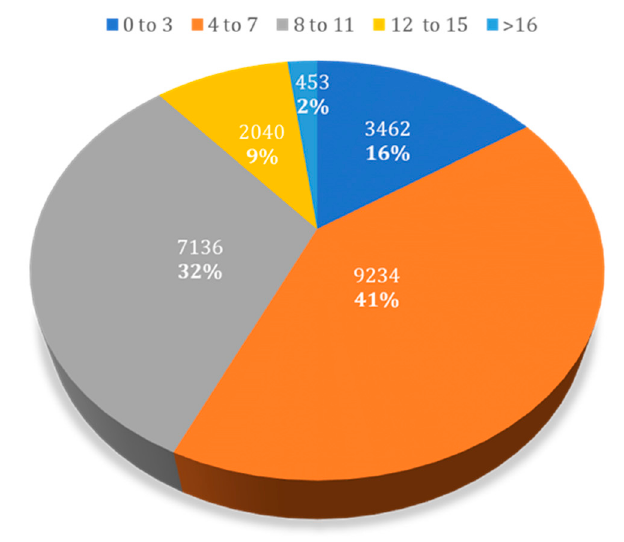
Figure 9. Relative distribution of active molecules present in the DUD–E database by the number of rotational bonds.